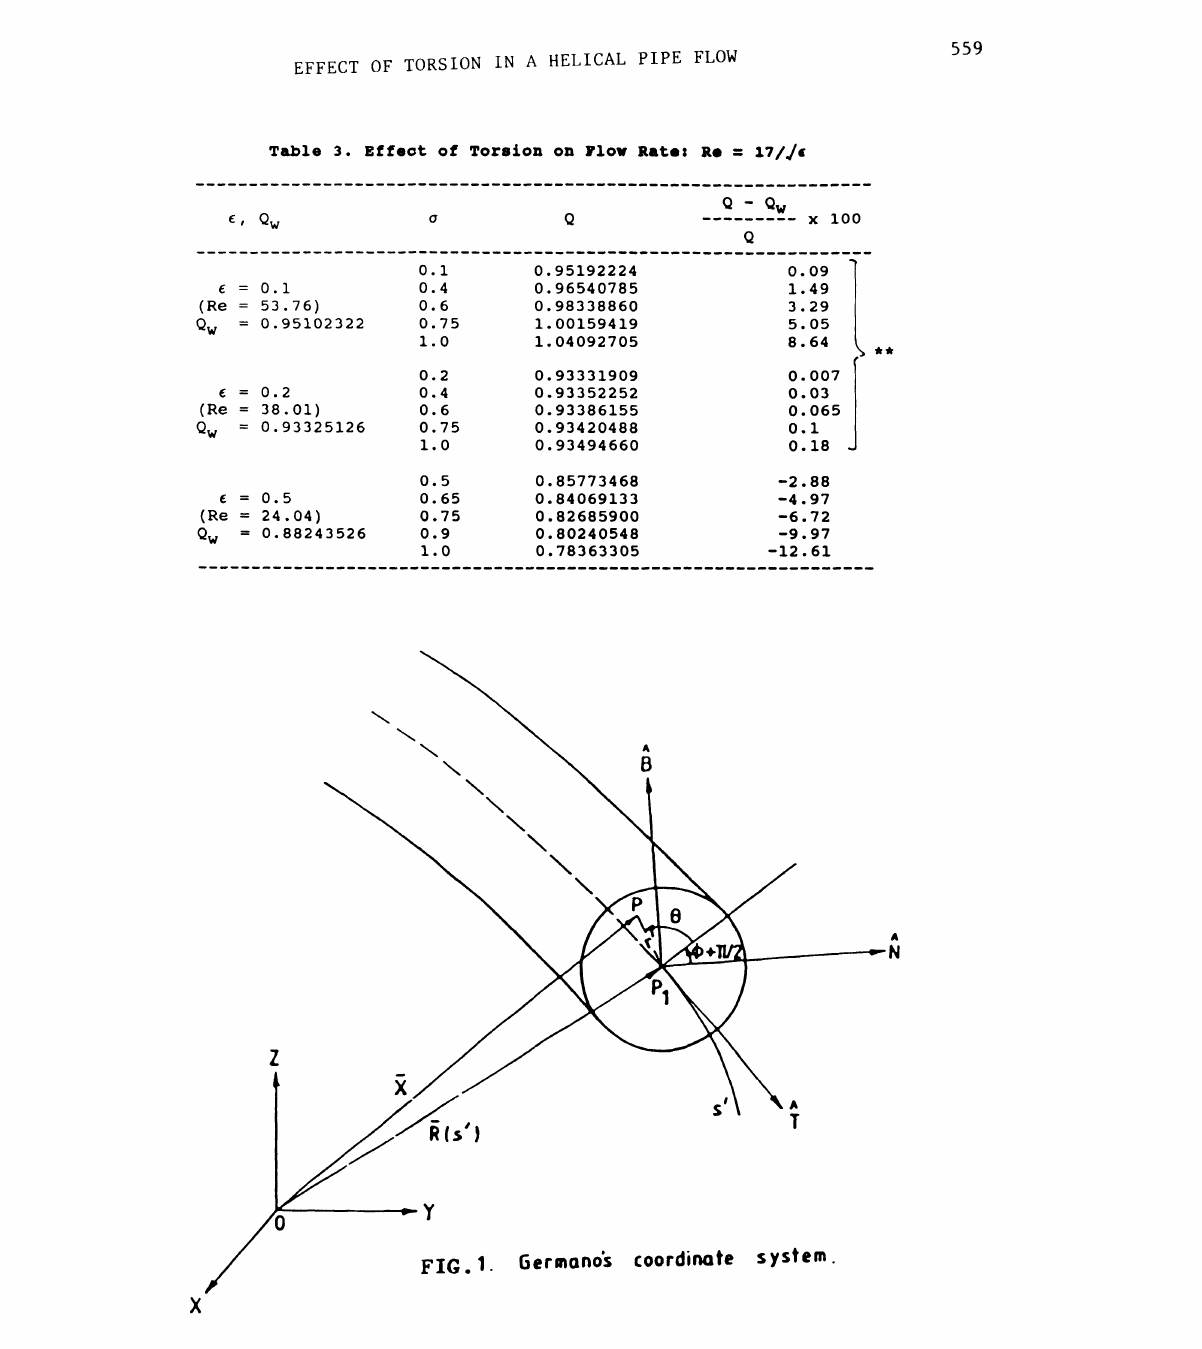
Table 3. Effect of Torsion on Flow Rates